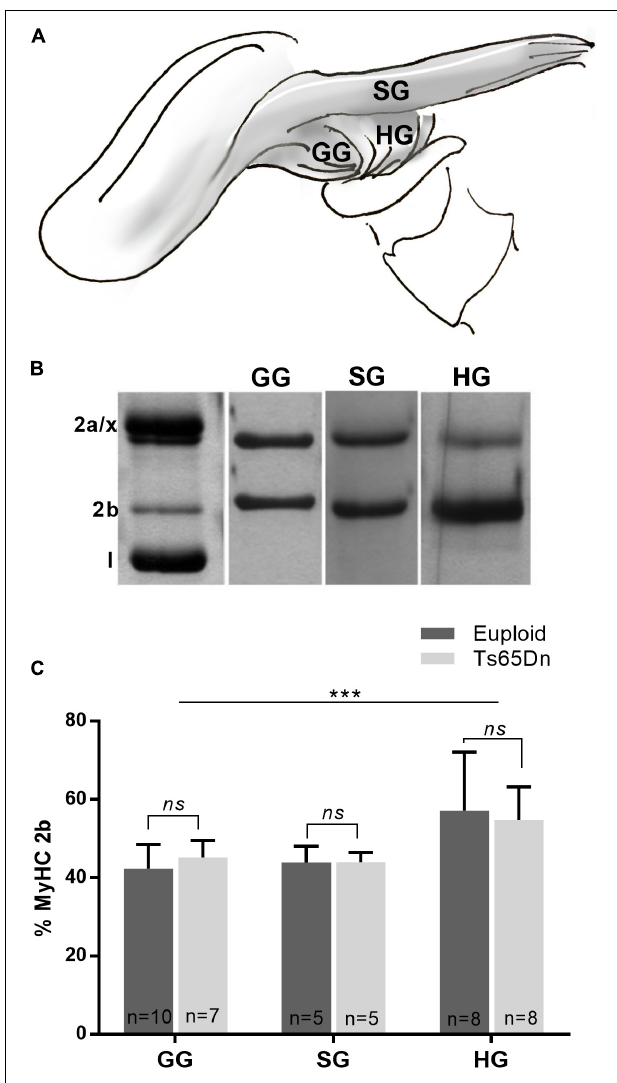
FIGURE 4 | MyHC analysis of male Ts65Dn mice across an adult age range. (A) The styloglossus (SG), hyoglossus (HG), and genioglossus (GG) are extrinsic tongue muscles. (B) Extrinsic tongue muscle myosin heavy chain (MyHC) isoforms separated by SDS-PAGE and silver stained. (C) Relative proportion of MyHC 2b in extrinsic tongue muscle samples from mice across an adult age range. Bars indicate mean and SD. ∗∗∗ p ≤